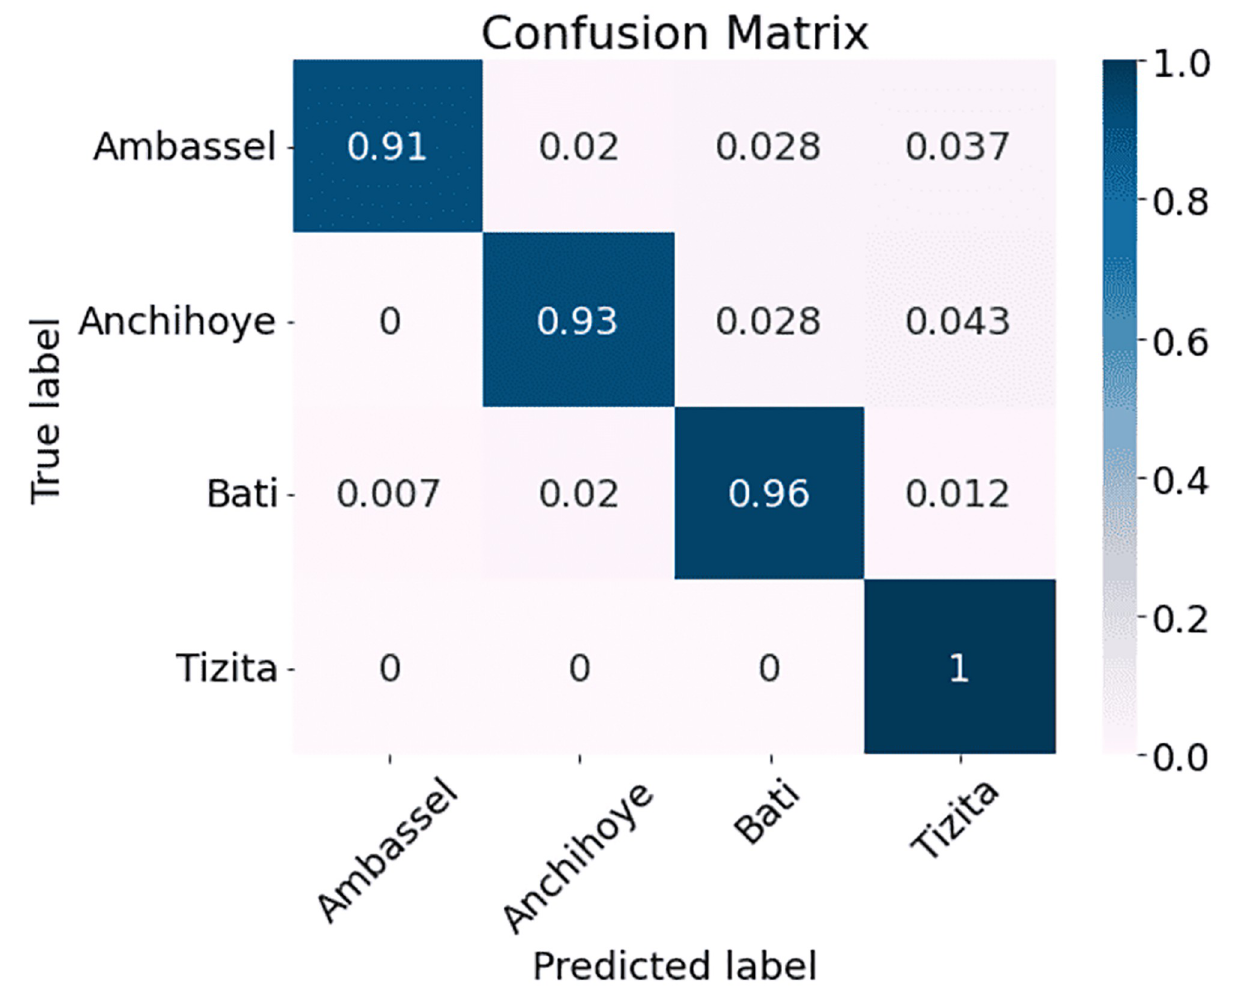
Fig 5. Experiment 1: EKM confusion matrices using MFCC on EMIR.